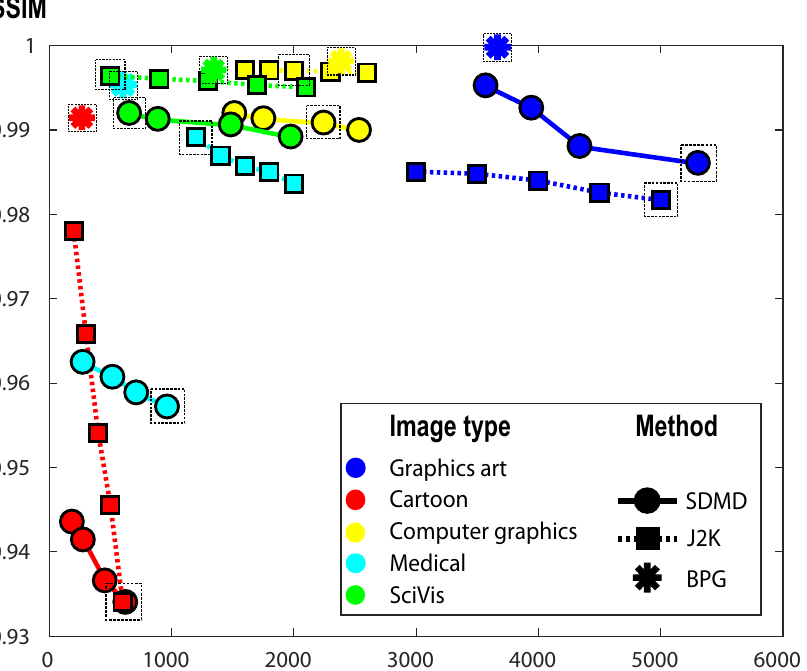
Figure 14. A comparison of SDMD (dots), JPEG 2000 (squares), and BPG (stars) for a graphics art image (blue), a cartoon image (red), a computer graphic (yellow), a medical image (cyan), and a SciVis image